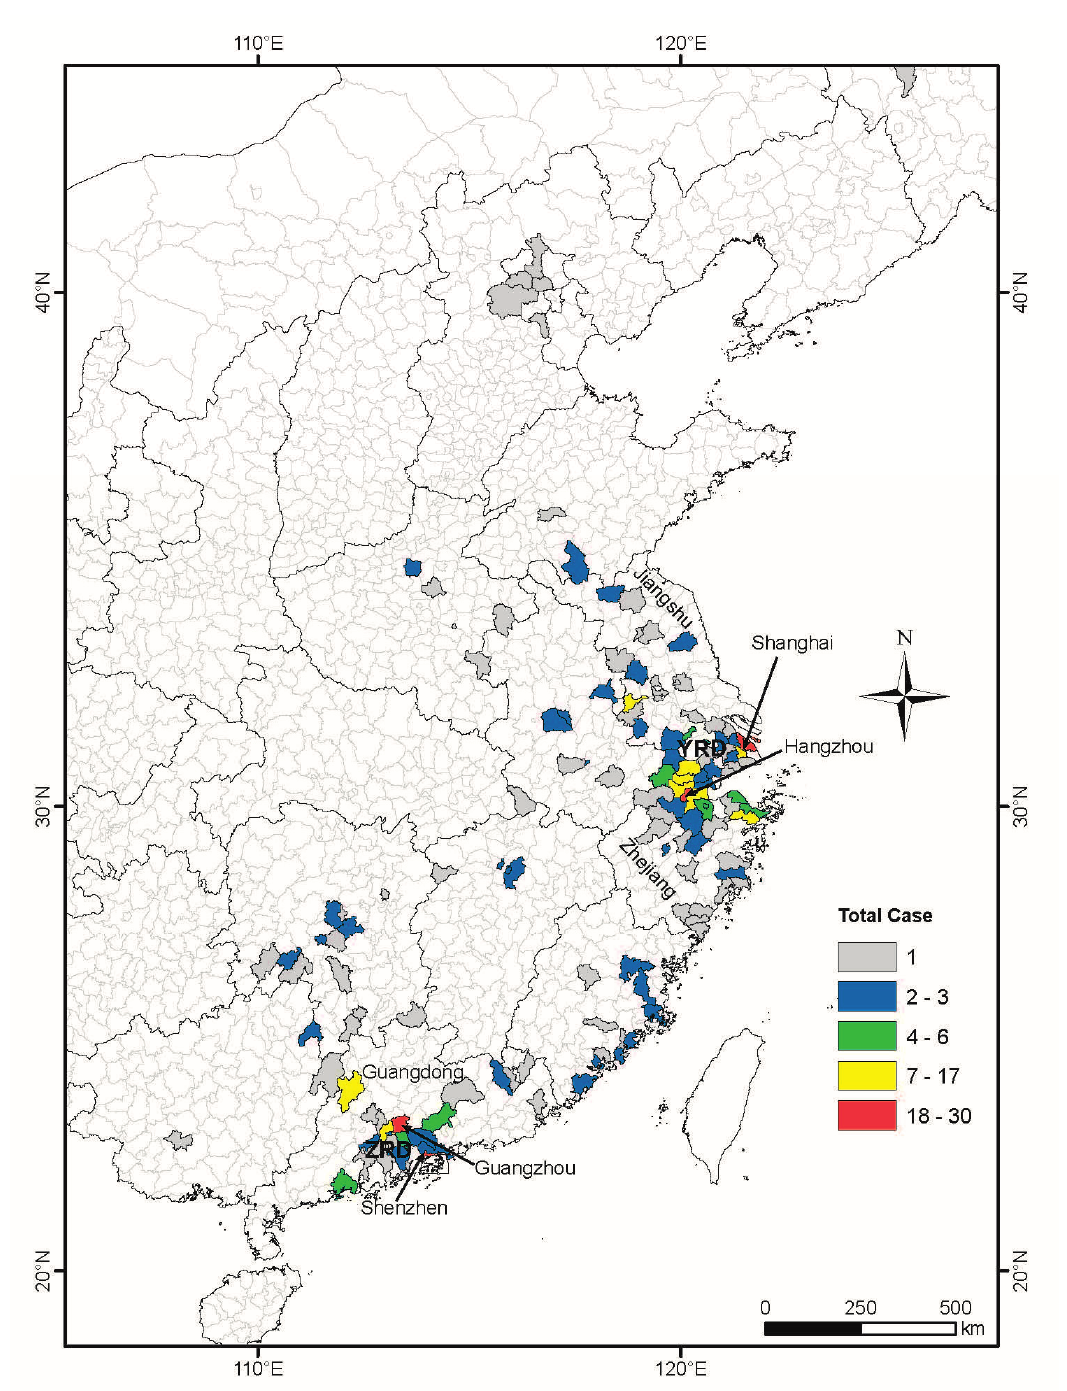
Figure 2. Distribution of H7N9 cases at county level in China from the 19 February 2013 to 31 March 2014. County and province boundary data was accessed from Chinese National Fundamental Geographic Information System (www.nfgis.nsdi.gov.cn) in May 2014. Provinces (Guangdong, Zhejiang and Jiangsu) and cities (Shenzhen, Guangzhou, Hangzhou and Shanghai) mentioned in the paper are marked out. YRD: Yangtze River delta, PRD: Pearl River